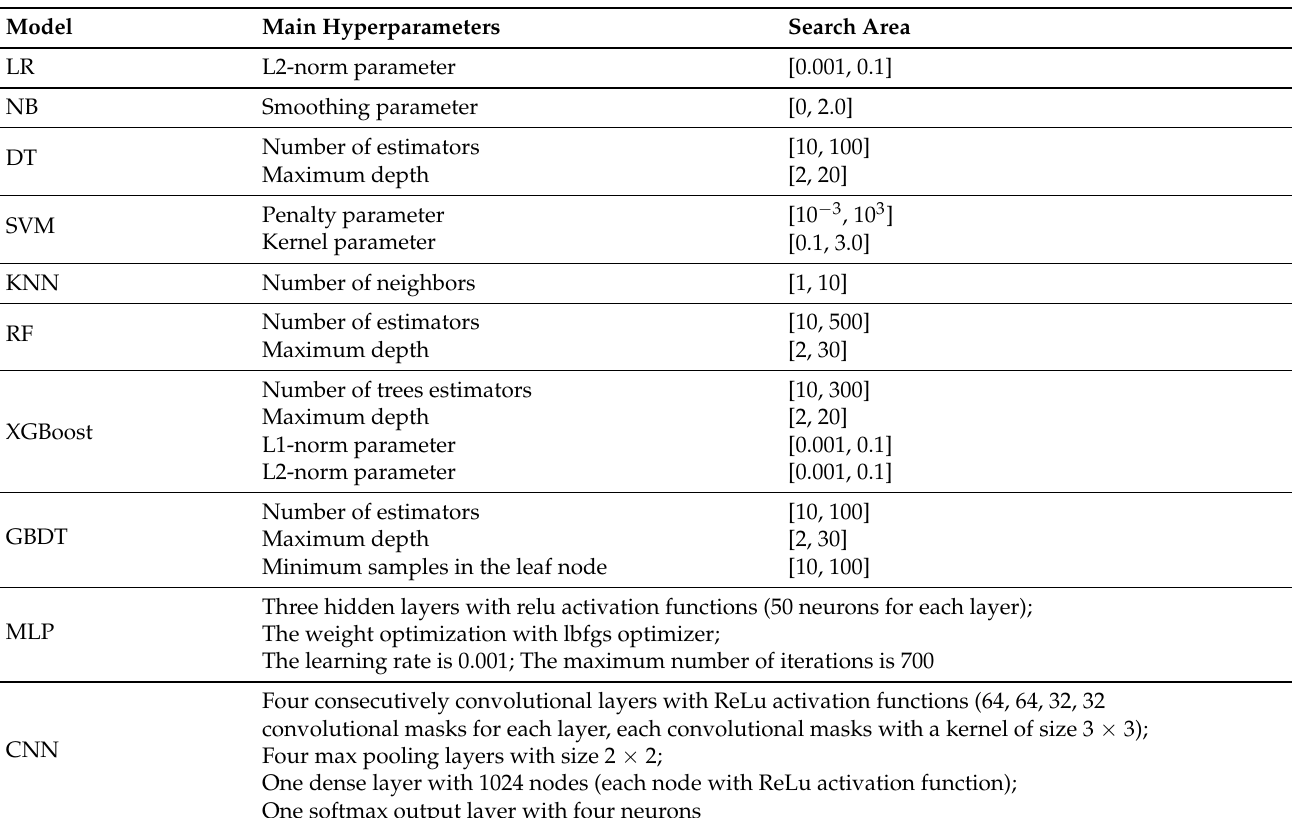
Table 3. The main hyperparameters of each model (except for the convolutional neural network (CNN), other parameters of the model are the default values in Scikit-learn).